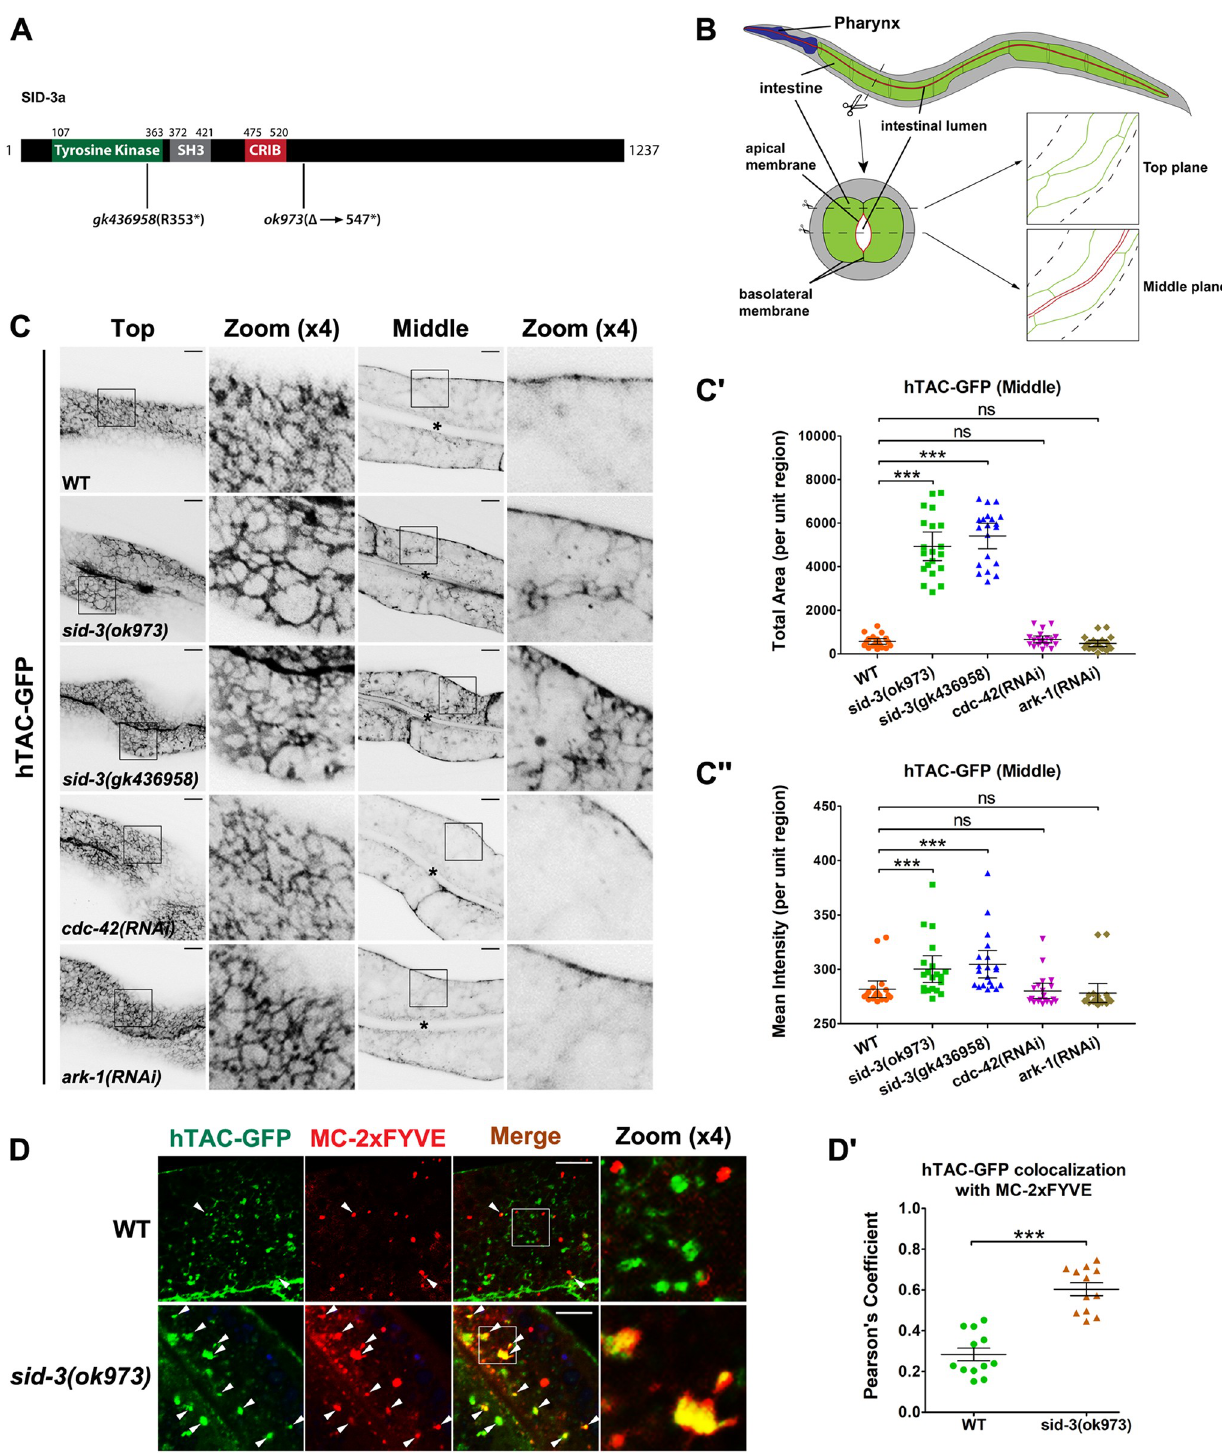
Fig 1. SID-3 is required for sustaining recycling transport in intestinal epithelia. ( A ) Domain architecture of SID-3a. SID-3a contains an N-terminal tyrosine kinase domain, an SH3 (src homology 3) domain, a CRIB (CDC42/RAC interacting binding) domain, and a highly variable C-terminal region. sid-3 mutant alleles and the corresponding sequence changes were indicated. Δ : deletion; � : stop codon. ( B ) A diagram of the worm intestine, indicating the apical and basal membrane and the top and middle focal planes of the confocal microscopy. Imaging plane close to the basal membrane is defined as "Top", and the imaging plane where the apical membrane and lumen can be observed is defined as "Middle". ( C-C @ ) Confocal images of the worm intestinal cells